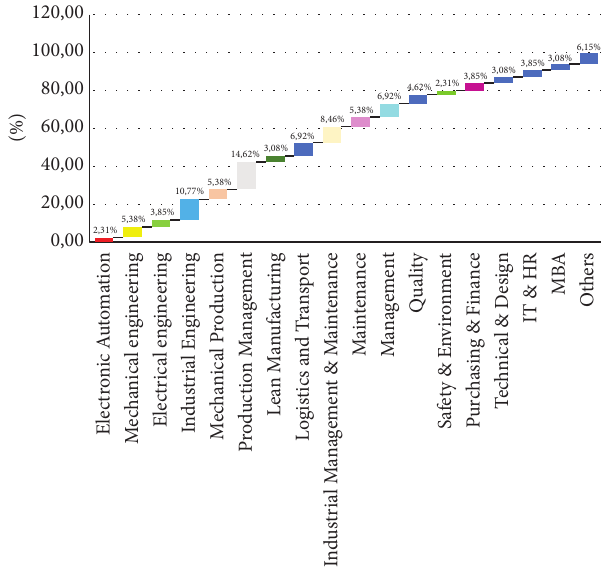
Figure 10: Level of education of respondents.